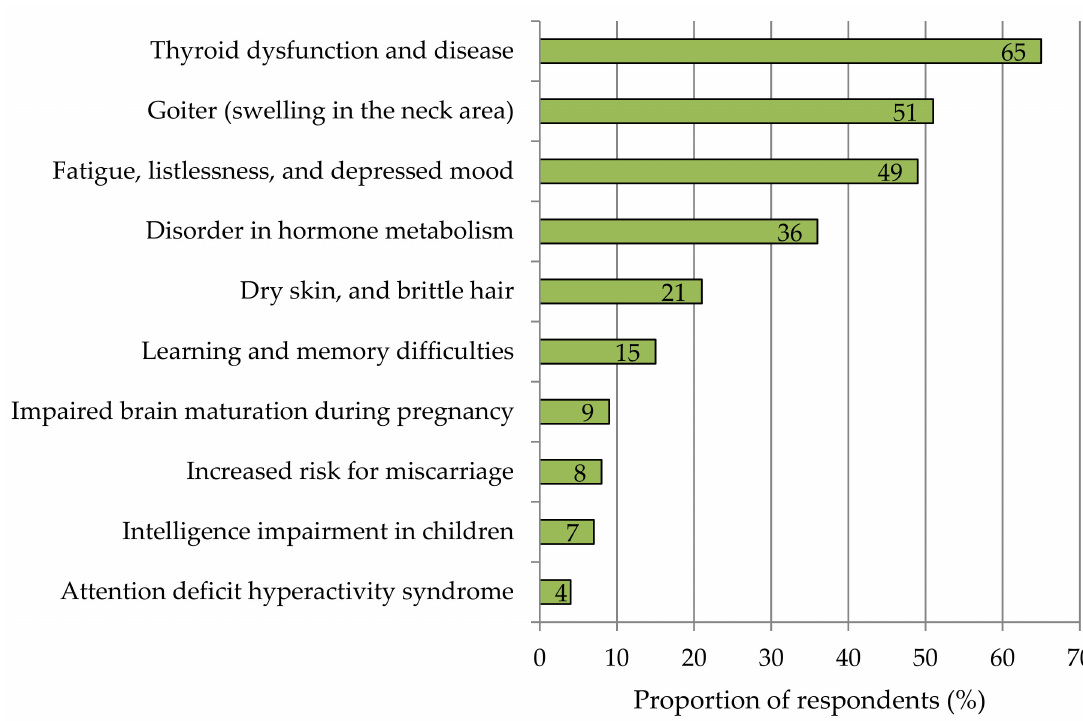
Figure 1. Respondents’ estimation of which of the health impairments presented can be attributed to iodine deficiency. Multiple answers were allowed. n =